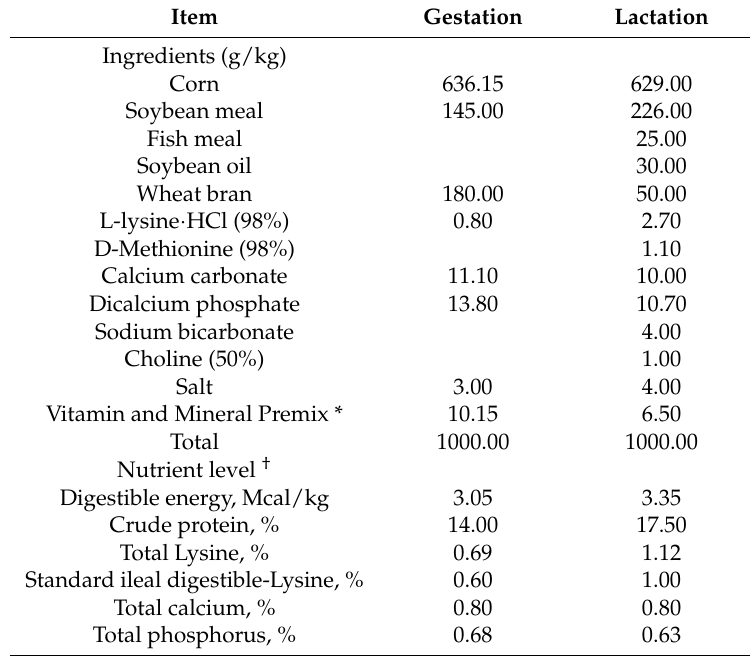
Table 1. Ingredients and nutrient composition of basal diets fed to sows throughout gestation and